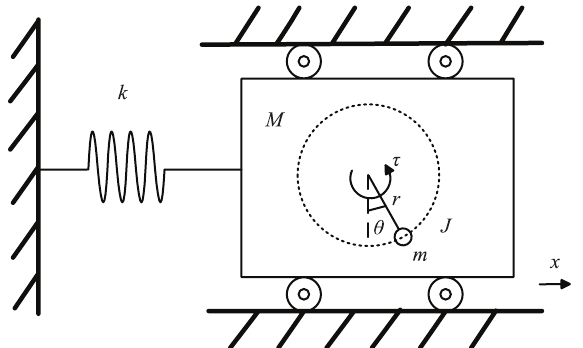
Figure 1. Physical structure diagram of an underactuated horizontal TORA